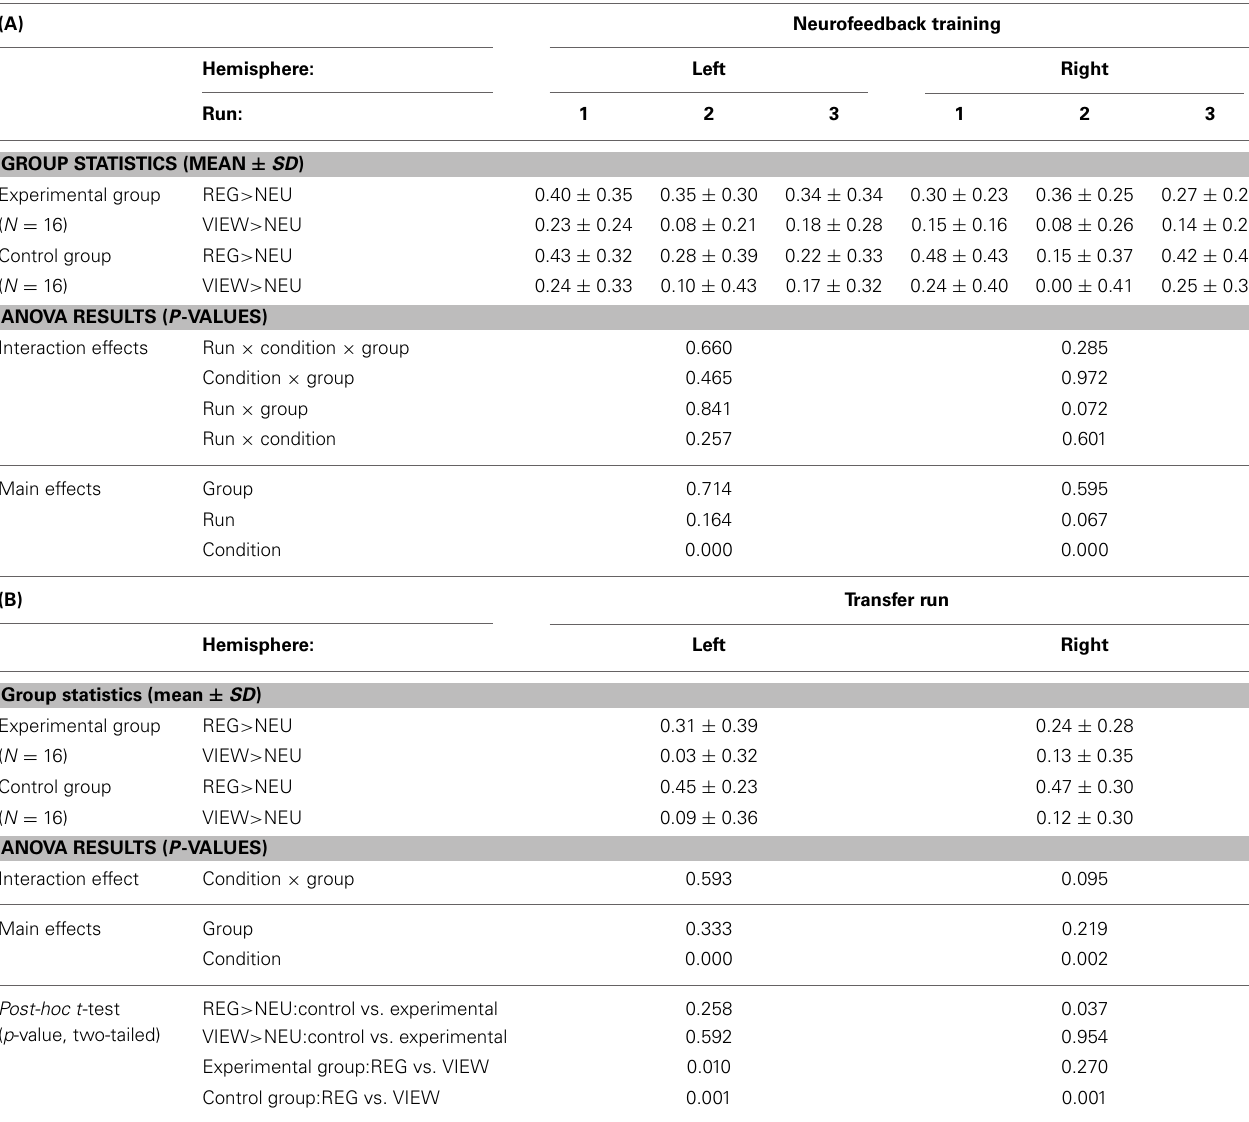
Table shows parameter-estimate-contrast values from the anterior insula spheres. (A) Neurofeedback training, (B) Transfer run. SD, standard deviation; REG, regulate; NEU,